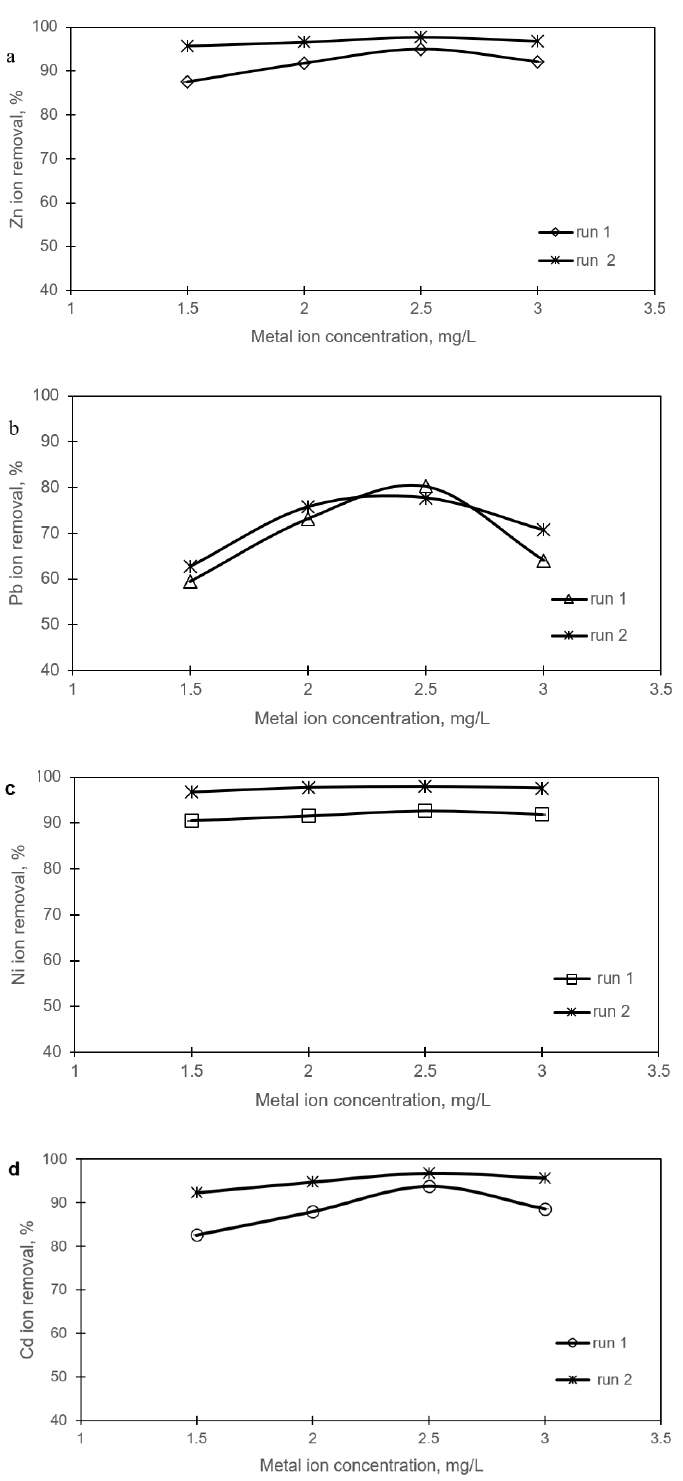
Figure 4. Effect on metal ion removal: ( a ) Zn, ( b ) Pb, ( c ) Ni, and ( d ) Cd at pH 10, using 800 mg/L of 10% TBPF in 1.5 to 3 mg/L metal ion concentrations.